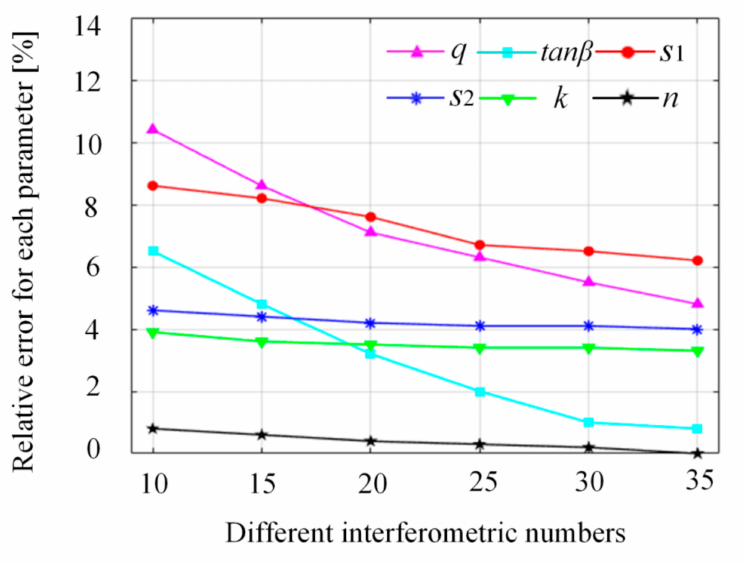
Figure 4. Relative errors with different interferometric numbers under multi-master connection.